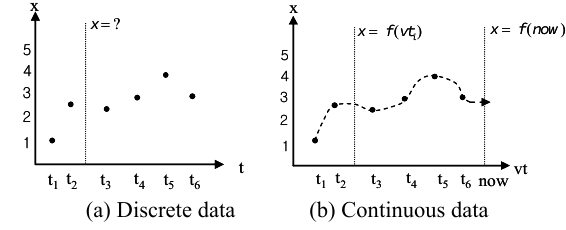
Figure 2. Representation of moving points and values  MovingPoint : MovingPoint is a type to represent locations changes of moving objects as like GPS data of a taxi.